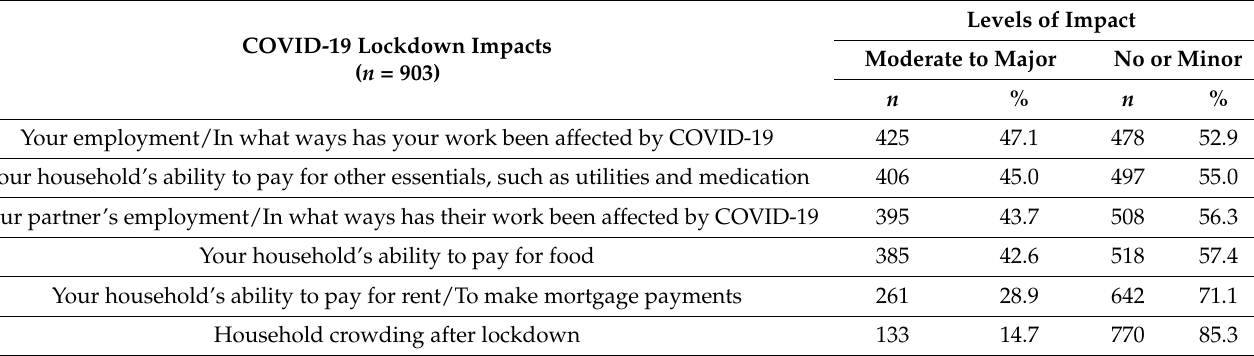
Table 2. The perception of the nationwide COVID-19 lockdown impacts.